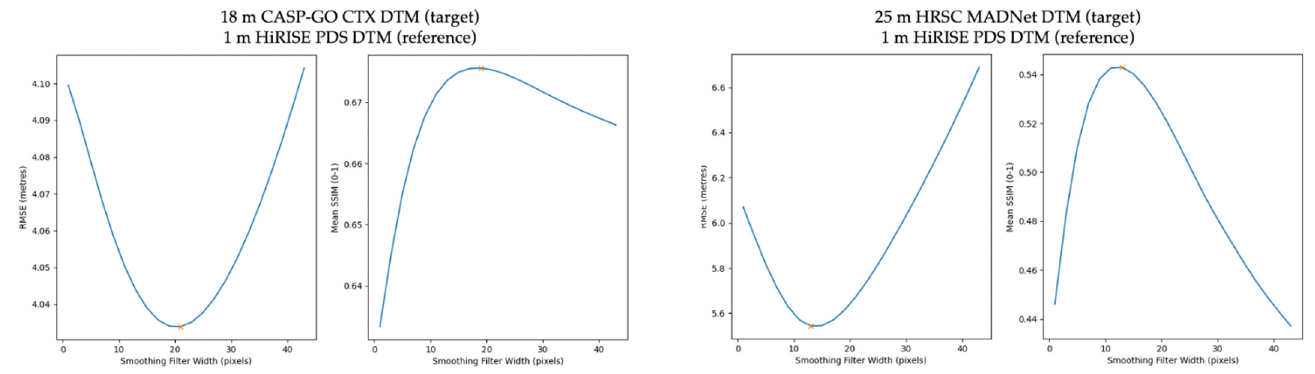
Figure 9. Left: RMSE and SSIM plots of the target 18 m/pixel CASP-GO CTX DTM (J01_045167_1983_XN_18N024W-J03_045800_1983_XN_18N024W-DTM [28]) and the reference 1 m/pixel HiRISE PDS DTM (DTEEC_039299_1985_047501_1985_L01); Right: RMSE and SSIM plots of the target 25 m/pixel HRSC MADNet DTM [28] and the reference 1 m/pixel HiRISE PDS DTM